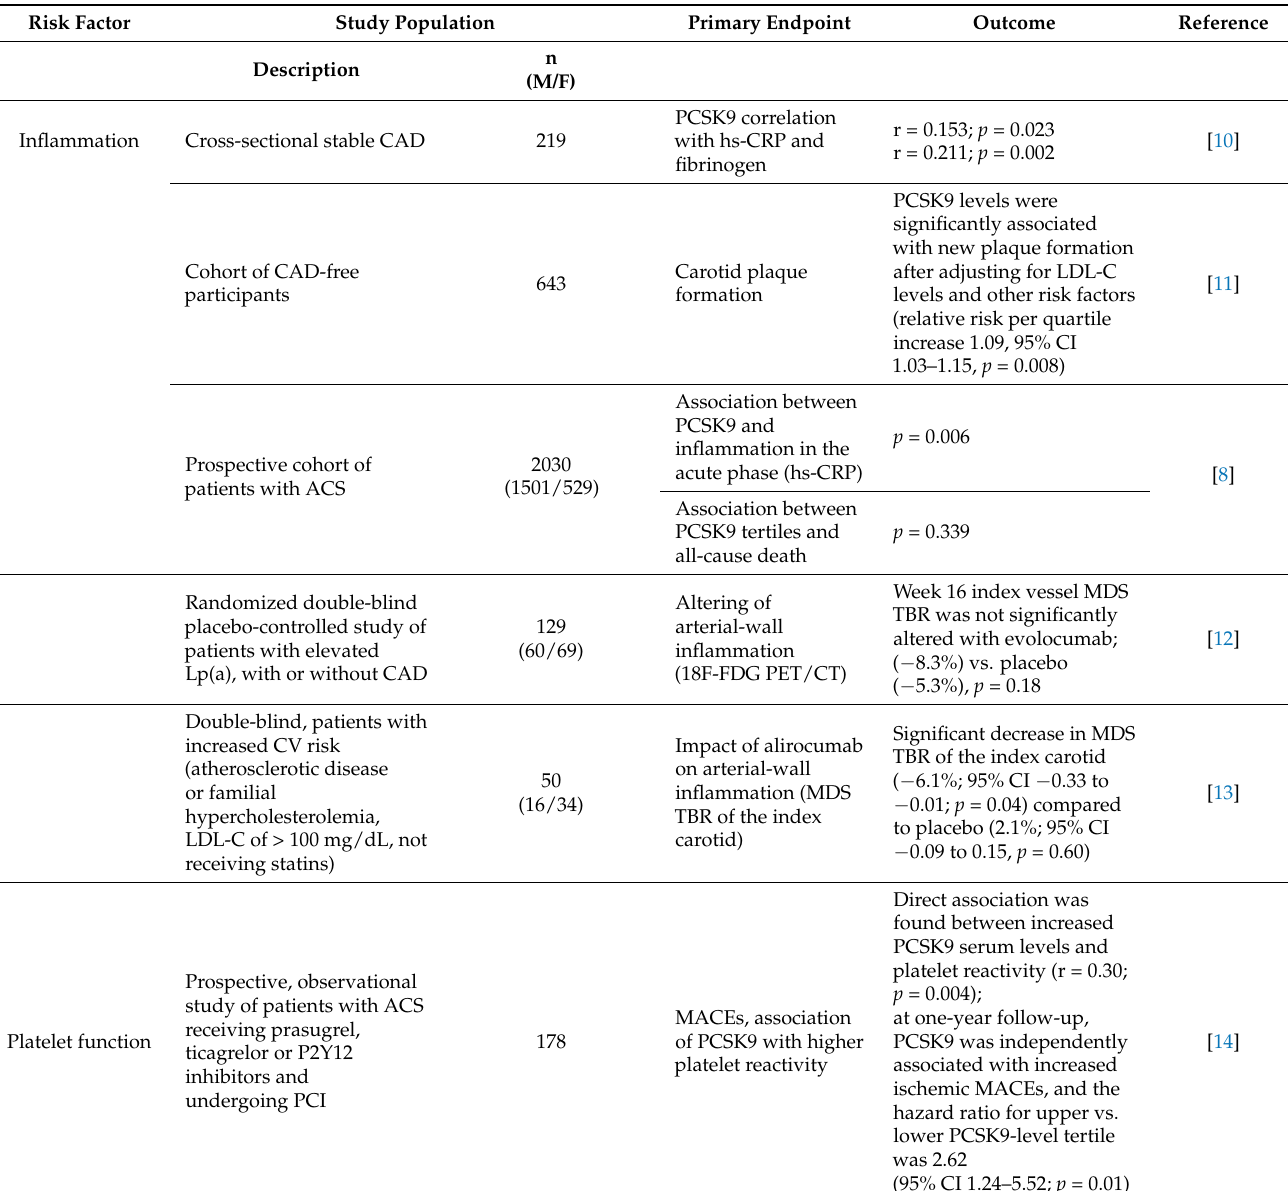
Table 1. Overview of the clinical studies that have evaluated the effects of PCSK9 on atherosclerotic risk